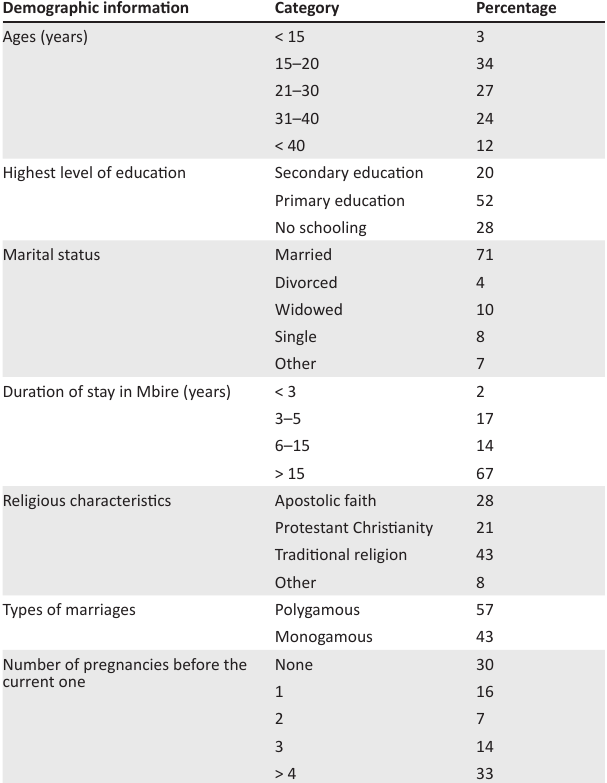
TABLE 2: Demographic information of pregnant women in the Mbire district. Demographic